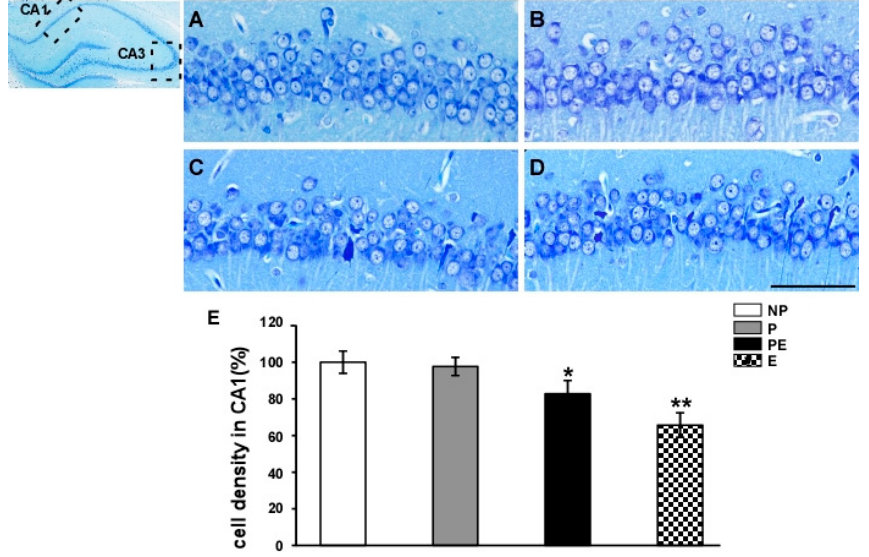
Figure 1. The number of surviving neurons in the CA1 area was detected by Nissl staining ( n = 6). ( A ) NP group; ( B ): P group; ( C ) PE group; ( D ) E group; Quantitative analysis was used to reveal differences in the number of surviving neurons in the CA1 area in all groups ( E ). * p < 0.05, PE and E groups vs. NP and P groups. ** p < 0.05, PE group vs. E group. Scale bar = 100 µm.